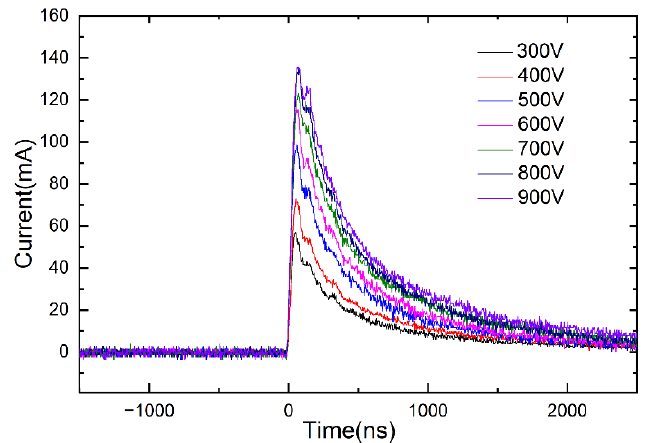
Figure 6. Linear current waveforms of the switch triggered by the pulsed spark discharge; the storage capacitor was 0.1 nF.